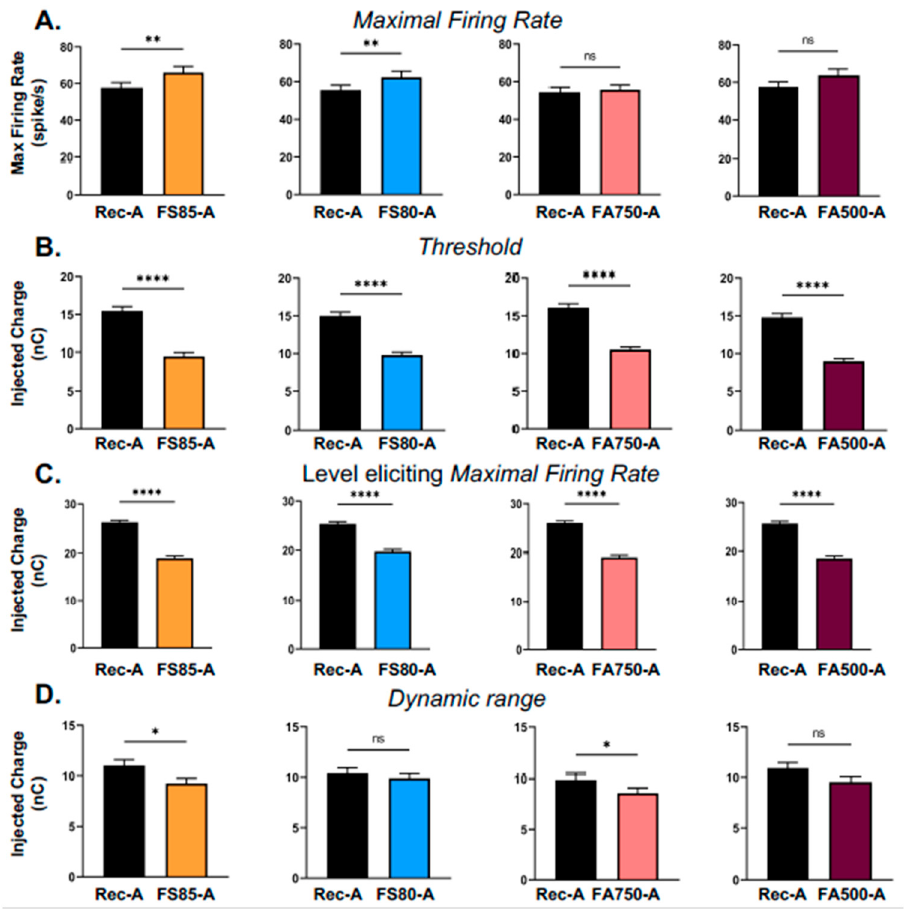
Figure 5. Mean values (± sem) obtained for four parameters of the evoked responses with the rectangular pulses and the four types of anodic-first ramped pulses. The conventions are the same as for Figure 4. ( A ) The maximal evoked firing rate (MaxFR); ( B ) The threshold; ( C ) The charge level at which the MaxFR was observed; ( D ) The dynamic range. Note that in general, the effects obtained with the anodic-first pulses were similar to those described with the cathodic-first pulses on Figure 4: the MaxFR was significantly increased in two out of four cases; the thresholds were significantly decreased and so were the charge levels eliciting the MaxFR. The dynamic ranges were either unchanged or slightly decreased. See Table 2 for the mean values (± sem) and the p values. The numbers of recordings and animals involved in each comparison are provided in Table 2. (* p < 0.05; ** p < 0.01; **** p < 0.001; ns: not significant). Table 2. Mean ± sem of the parameters extracted from the responses of ACx neurons with anodic- first pulses. For each comparison, N refers to the number of animals and n refers to the number of recordings providing significant responses to both pulse shapes.